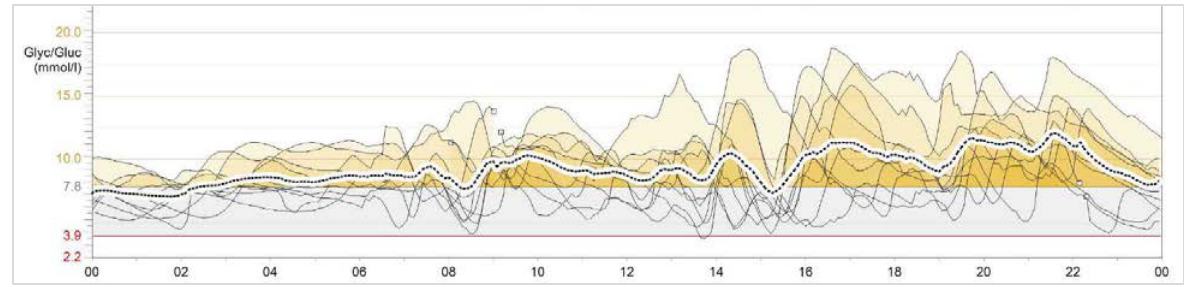
Figure 2: Continuous monitoring of blood glucose (mmol/l) with multiple-dose insulin injections and prandial insulin administered 15 minutes before the start of meals. Solid lines represent the record of six individuals and consecutive days. The dotted line is the average of the six recorded days. The shaded zone represents the target glucose value.